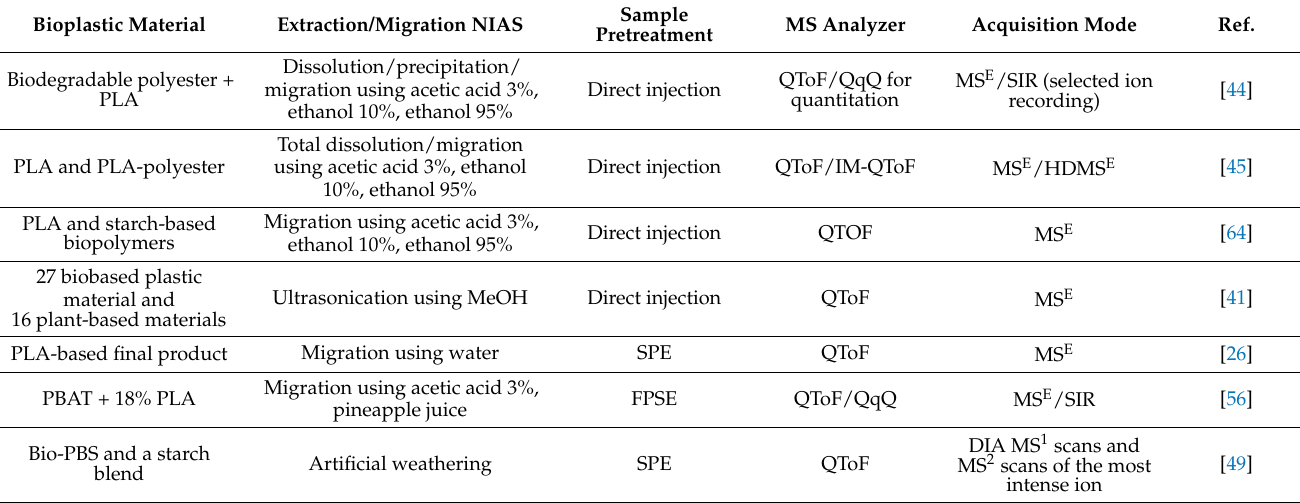
Table 2. LC-MS methods for the investigation of non-volatile NIAS in